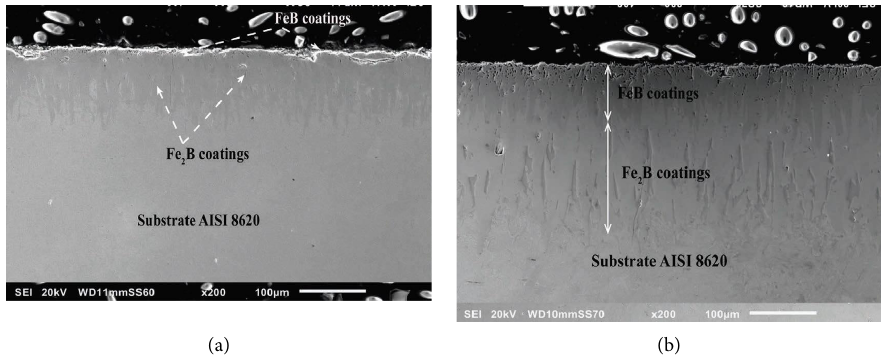
Figure 4: SEM micrographs on AISI 8620 borided for 6h; (a) 1173K and (b)